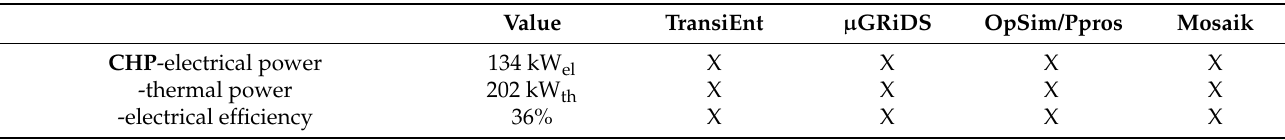
Table 5. Main parameters used for the simulation of CHP scenario. “X” denotes a check mark when the parameter is implemented in the corresponding model. Value TransiEnt µ GRiDS OpSim/Ppros Mosaik CHP -electrical power 134 kW el X X X